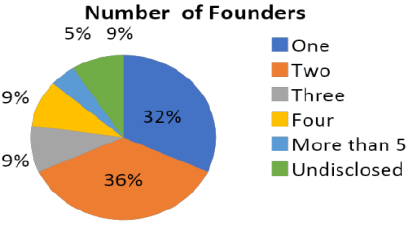
Figure 2: Number of Startup Founders